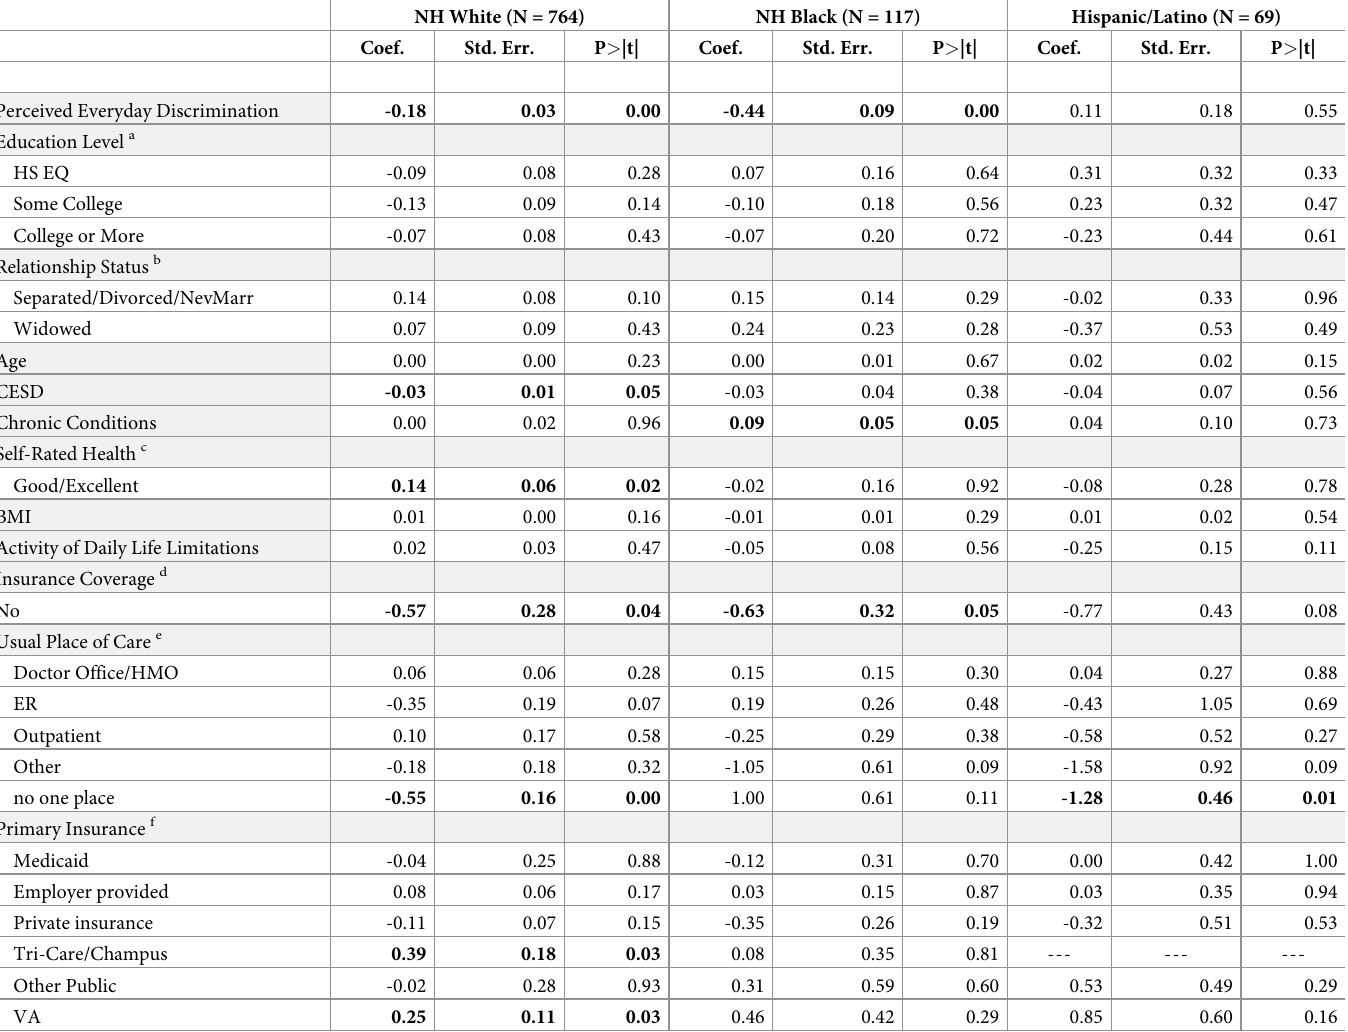
Table 2. Predictors of PCC (scaled) for men by race/ethnicity HRS, HCMS, PLBS 2010. NH White (N =